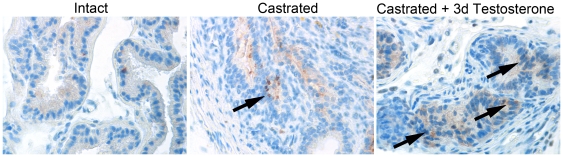
MSCs were recruited to the prostate during regrowth.GFP-MSCs (brown) were recruited to the prostates of mice at the indicated time points during regrowth. MSC recruitment was focal, and quantitation was performed for selected fields of view with detectable MSCs. Oneway Welch ANOVA allowing for unequal variances was used to test differences between the experimental groups and the intact group (n = 20), followed by a two-sample t tests with unequal variances. The omnibus of statistic from the ANOVA was 89.0 (p<0.0001). Two-sample t tests with unequal variances tests showed a statistically significant increase between intact (mean  = 7.25 cells per field of view) and castrated (mean  = 25.75 cells, probability <0.0001) and castrated +3dT (mean  = 38.55 cells, probability <0.0001).